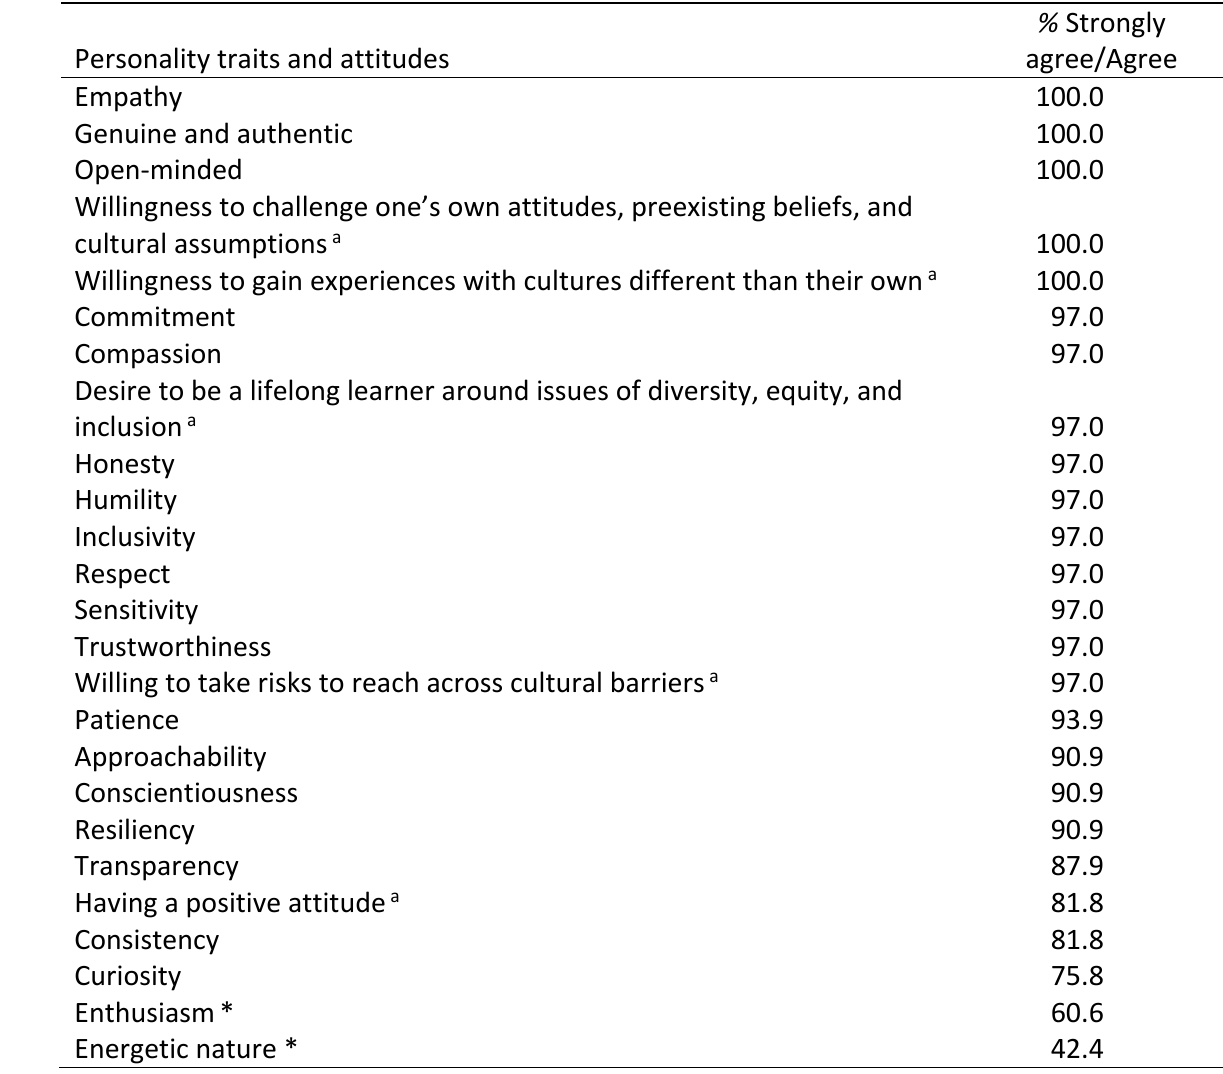
Table 2 Personality Traits and Attitudes Rated for Agreement by the Delphi Panel Based on Level of Importance for